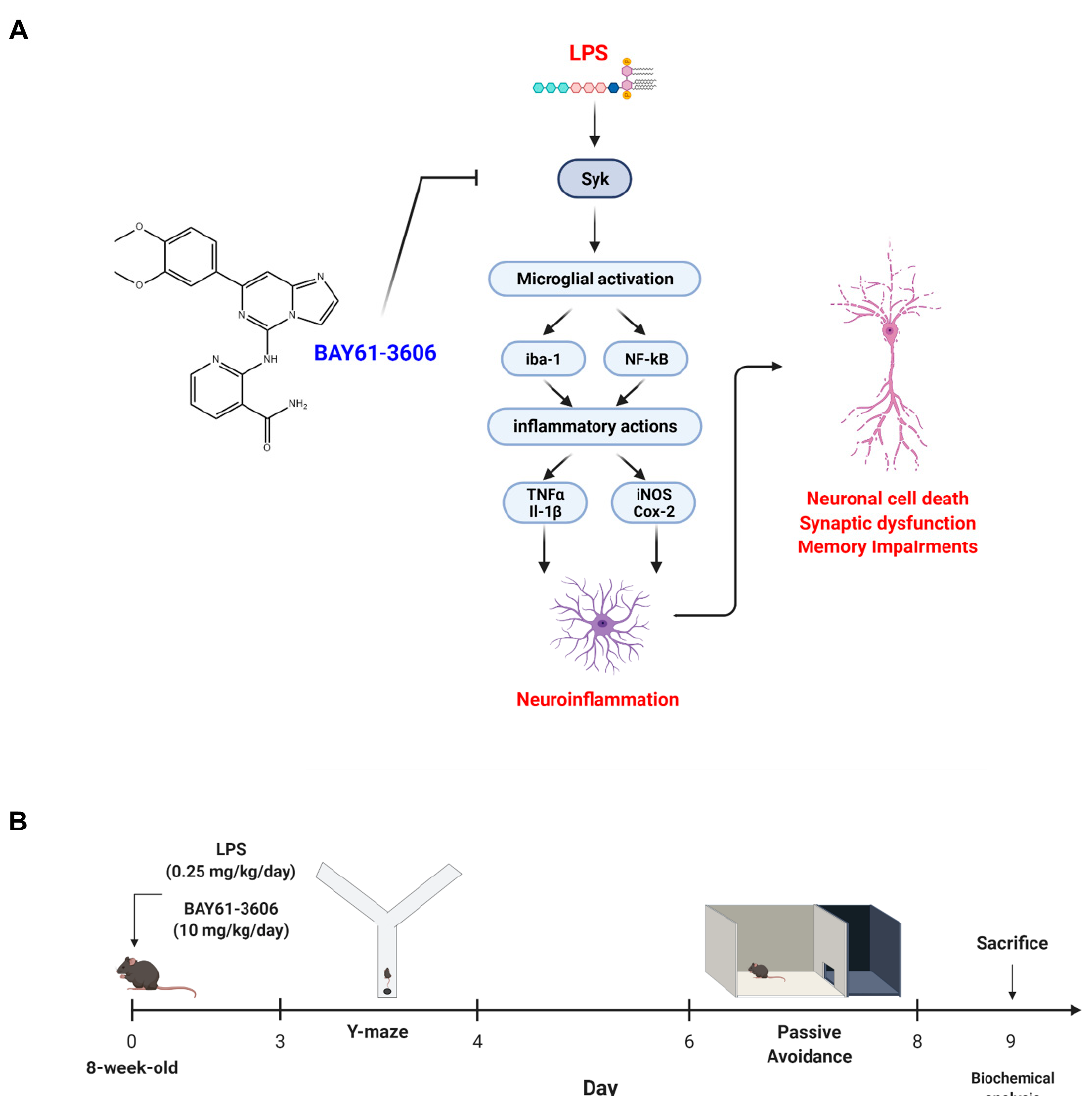
Figure 1. Study Design and Graphical abstract for the current study. ( A ) LPS stimulates microglial cells via enhancing the expression of Syk. Sequentially, microglia execute inflammatory actions through activation of NF- κ B, inflammatory mediators, and pro-inflammatory cytokines. This neuro- toxin promotes synaptic dysfunction and neuronal cell death, and finally leads to memory impair- ments. Pharmacological inhibition of Syk (via BAY61-3606) suppressed the overall inflamma- tion and neurodegeneration in LPS-treated in vivo and in vitro models. ( B ) Experimental scheme of LPS-induced mice model. LPS or LPS+BAY61-3606 were intraperitoneally treated in 8-week-old male mice until termination of experiment. Two kinds of behavior tests, Y-maze (3 days) and passive avoidance (6 days), were performed to measure spatial working memory and learning memory. Biochemical analyses were proceeded at the end of the behavior test. Abbreviations: LPS, lipopoly- saccharide; Syk, tyrosine-protein kinase; NF- κ B, nuclear factor kappa B.